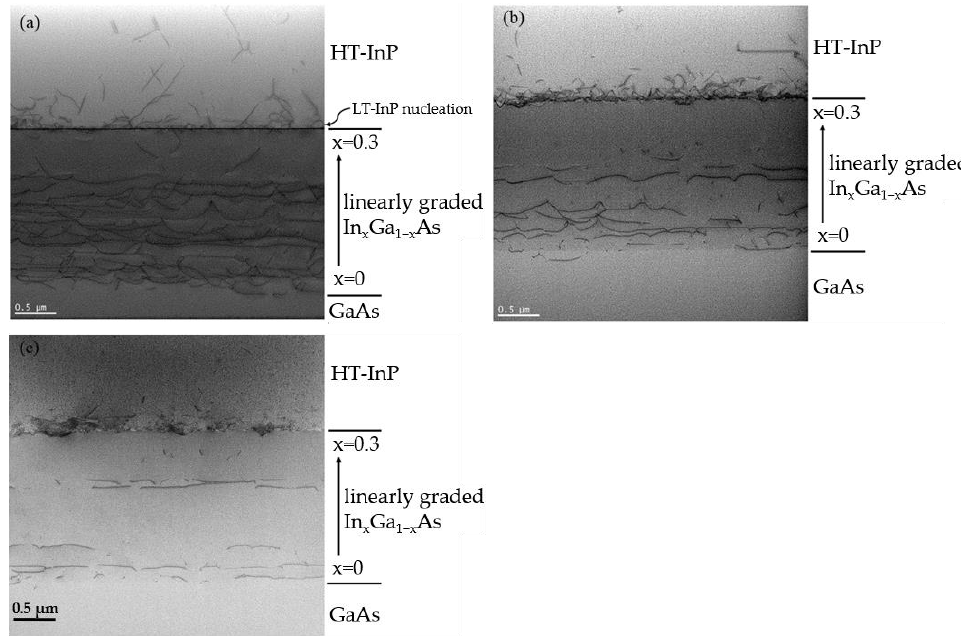
Figure 3. Cross-sectional TEM images of the virtual substrate plotted in ( a ) Figure 1b; ( b ) Figure 1c; ( c ) Figure 1d. ( c ) Figure